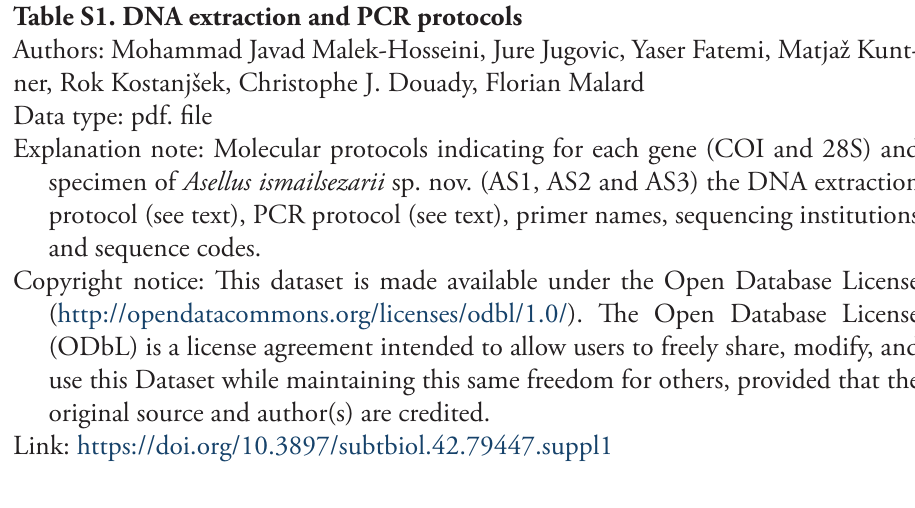
Table S1. DNA extraction and PCR